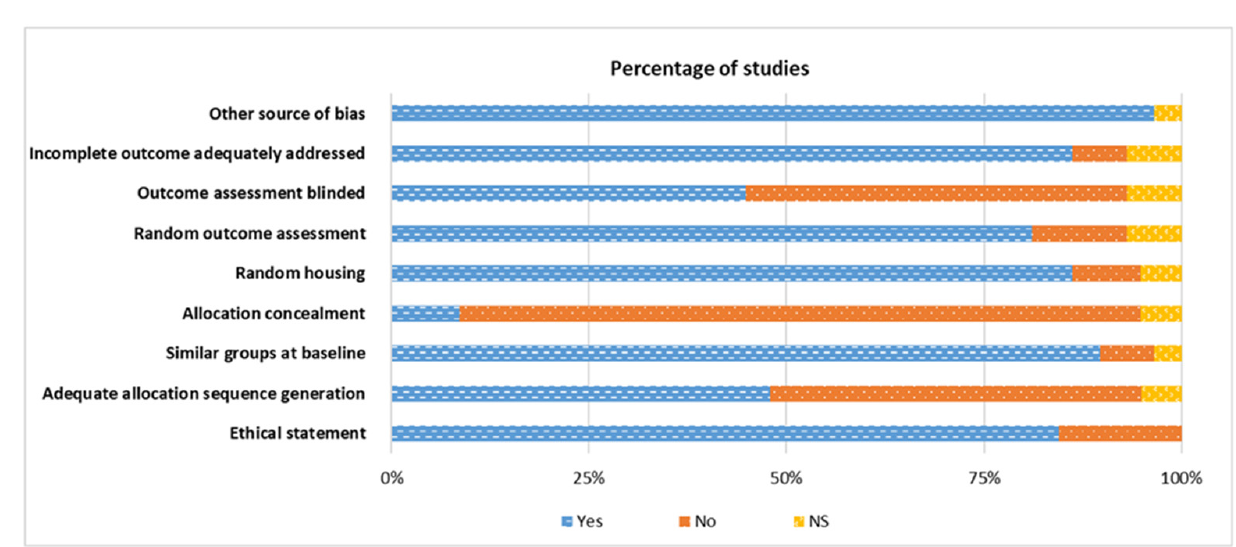
Figure 2. Qualitative evaluation of the risk of bias for the studies included in the systematic review. Yes: Percentage of studies scoring with low risk of bias. No: Percentage of studies scoring with high risk of bias. NS: Percentage of studies that did not specify the key methodological variables.